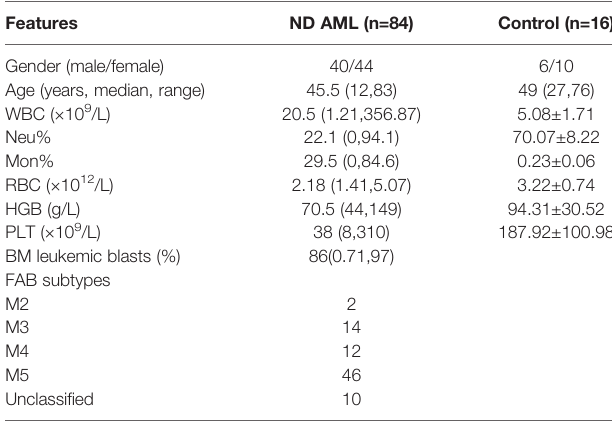
TABLE 1 | Clinical characteristics of ND AML patients and